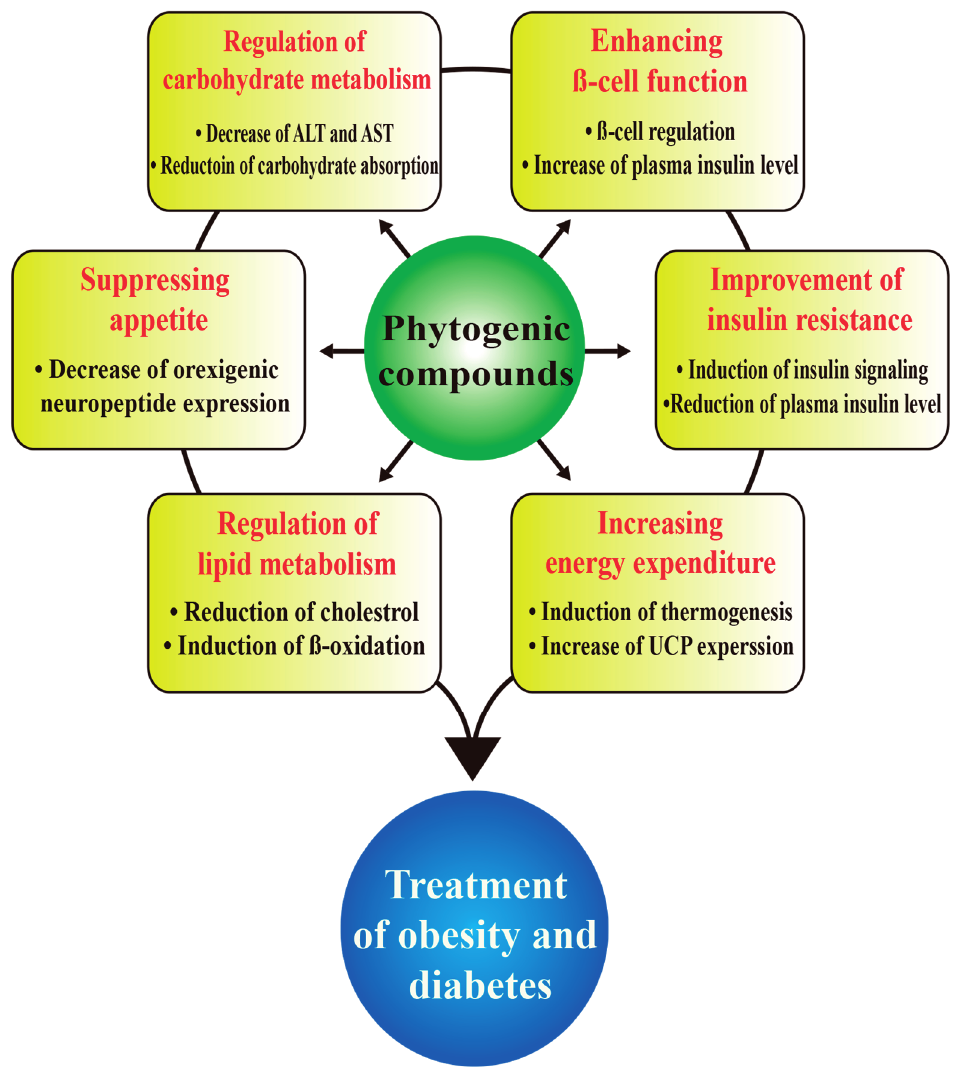
Figure 1. Effects of phytogenic compounds on diabetes and obesity. Possible outcome of phytogenic compounds as potential candidates for development of obesity and diabetes treatments are